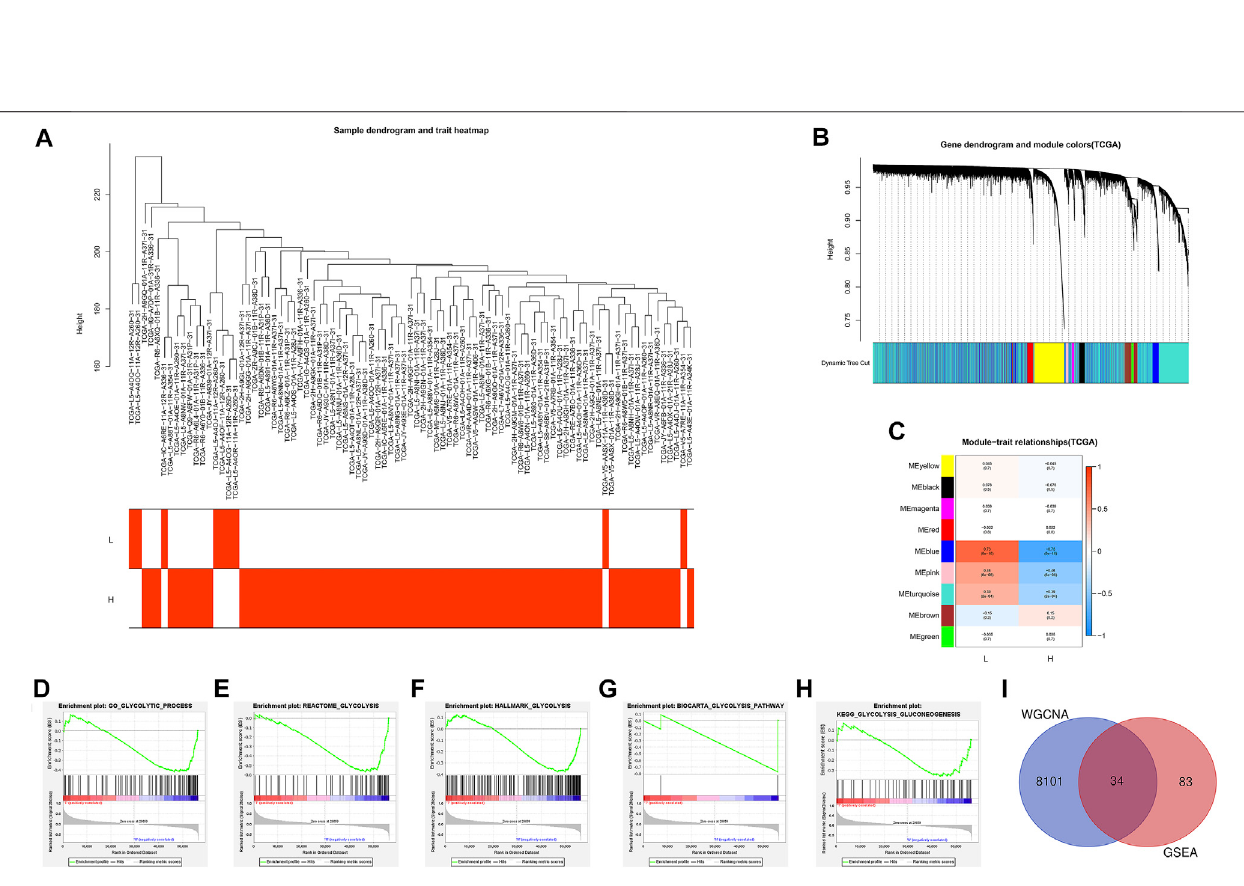
Frontiers in Genetics |